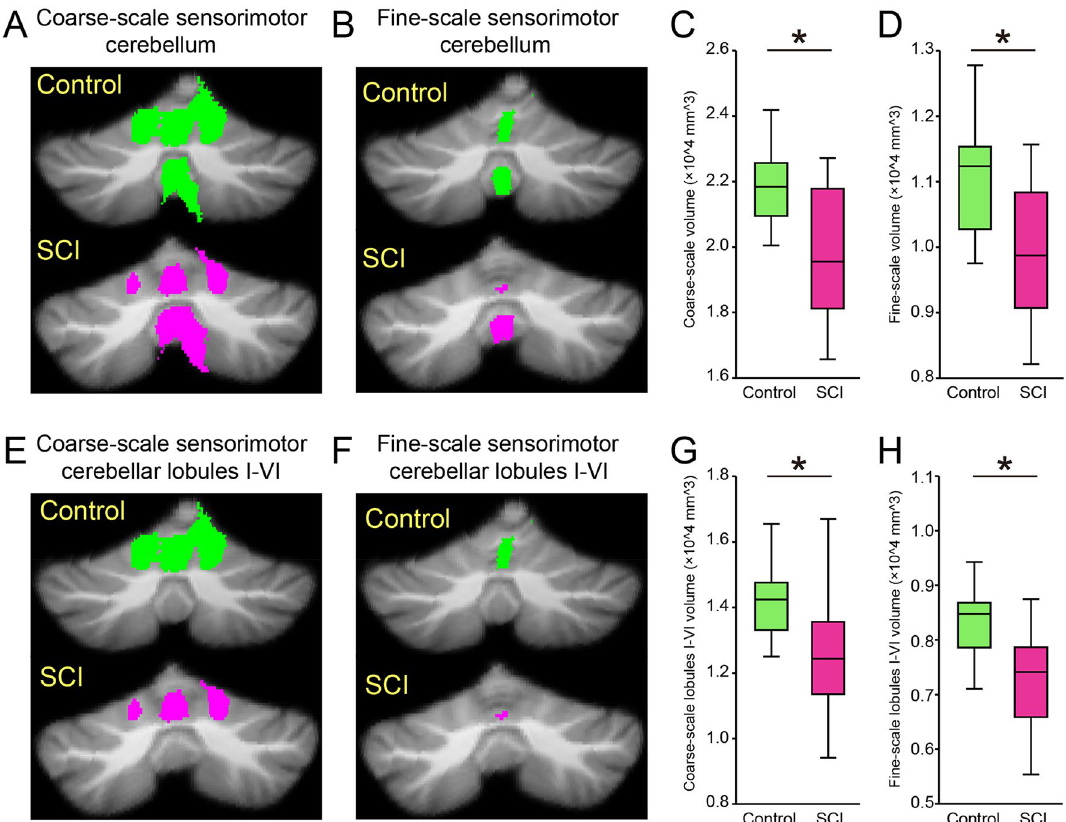
Figure 4. Structural MRI. ( A , B ), The coarse- and fine-scale sensorimotor cerebellum of a representative control (green) and SCI (magenta) subject. Note that the volume of coarse- and fine-scale sensorimotor cerebellum was smaller in SCI compared with control subjects. ( C , D ) Box-plot group data for the volume of coarse- and fine-scale sensorimotor cerebellum. ( E , F ) coarse- and fine-scale sensorimotor region in anterior and posterior cerebellar lobules identified in a representative SCI and control subject. Note that the volume of sensorimotor cerebellar lobules I–VI was also smaller in the SCI compared with the control subjects. ( G , H ) Box-plot group data for the volume of coarse- and fine-scale sensorimotor region in anterior and posterior cerebellar lobules I–VI. Error bars indicate SDs. *p <